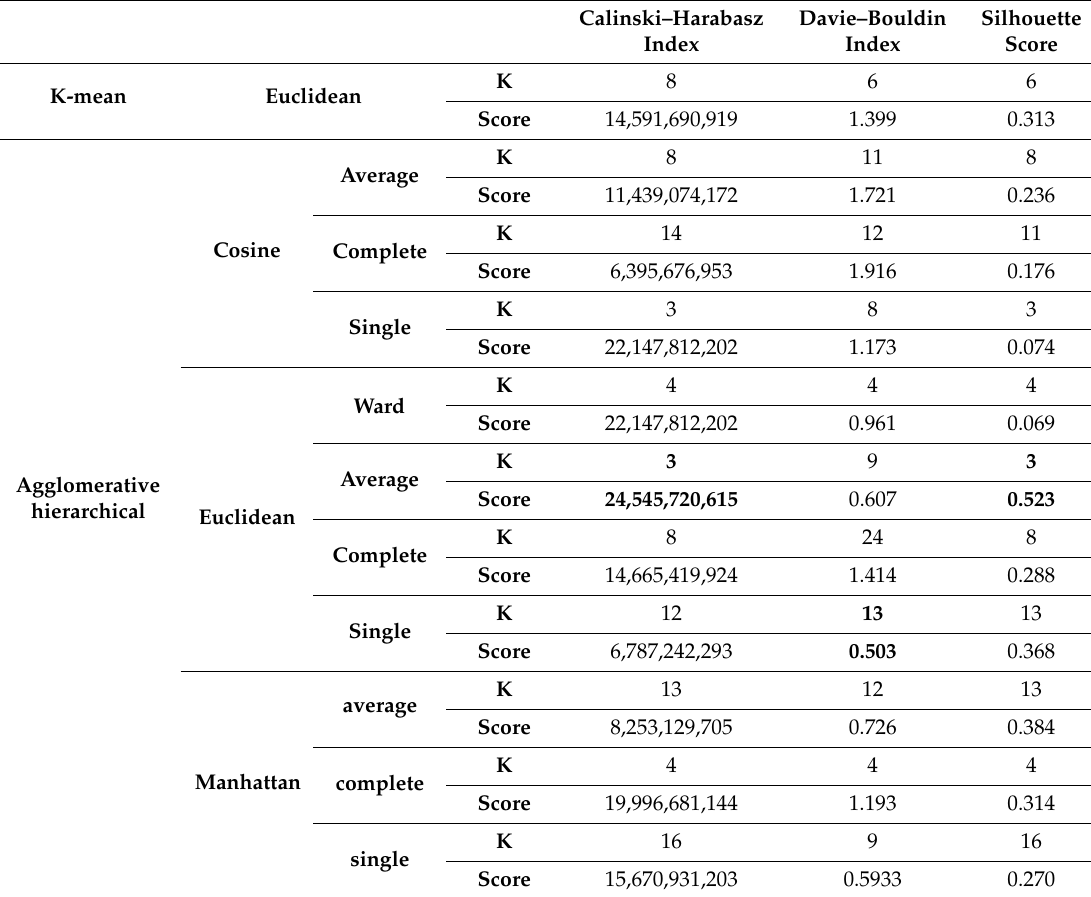
Table 6. Experiment one: results.